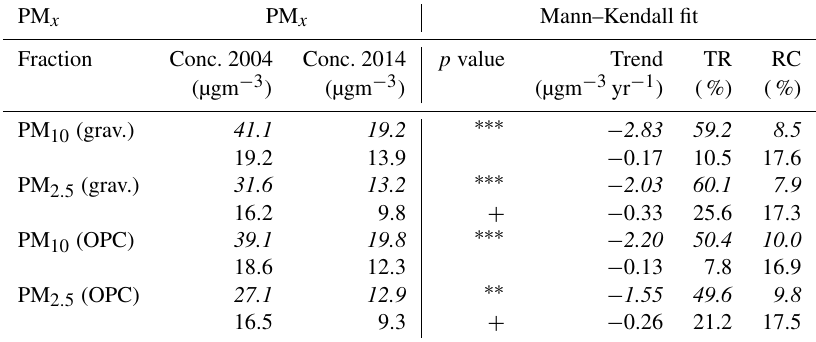
Table 1. Trends of different PM mass fractions from gravimetry (grav) and optical (OPC) measurements at BCN (italic) and MSY (2004- 2014). TR (%) is the total reduction; RC (%) is the residual component. Significance of the trends following the Mann–Kendall test: